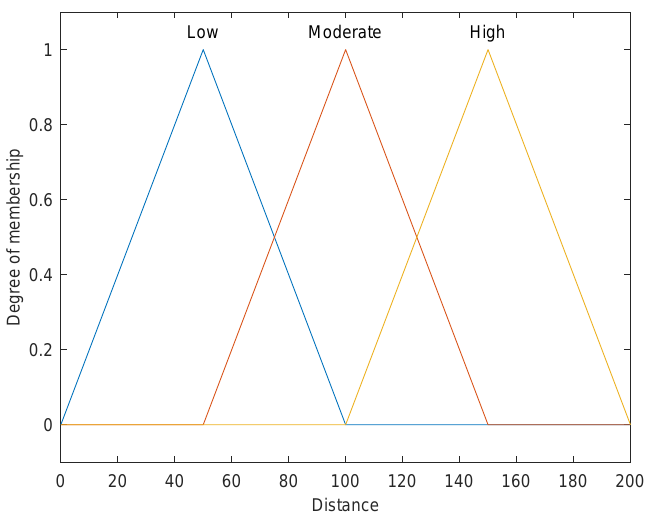
Figure 3. Membership function (MF) plot for input variable distance ( d ).